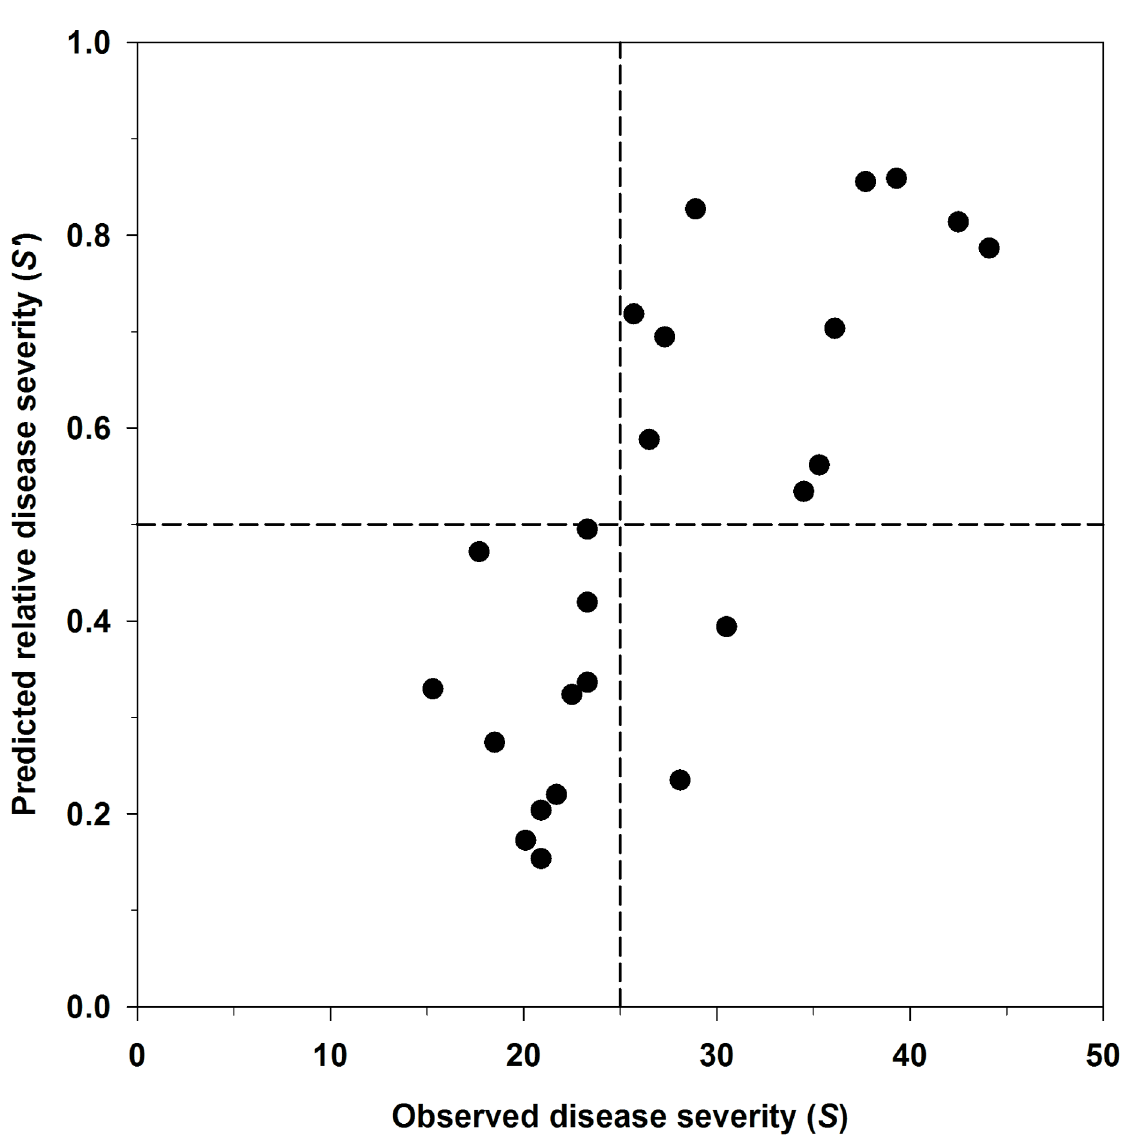
Fig 4. Evaluation of the prediction capacity of the infection model for Xanthomonasarboricola pv. pruni describing the combined effects of leaf wetness and temperature under greenhouse conditions. Comparison between observed disease severity ( S , 0–100 range) versus predicted relative disease severity ( S ’, 0–1 range) by the reduced form of Duthie’s model, Eq 5, on GF-677 peach-almond hybrid plants 21 days after inoculation. Leaf wetness durations from 3 to 6 hour were sufficient for infection and cause high disease severity at optimal temperatures (20–35˚C). Longer wetting periods resulted in increased dis- ease severity, and wetness periods from 12 to 24 h had the maximum effect on infection by the bacterium. The minimum leaf wetness period required for infection by X . arboricola pv. pruni depended on temperature, being short (3 h) at optimal temperatures and longer (6 to 12 h) at temperatures below 20˚C. These results confirm that wetness is required for the infection of X . arboricola pv. pruni on Prunus [25–27]. At 0 h wetness duration no disease symptoms were observed on the majority of plants. The few infections that did occur with 0 h wetness can likely